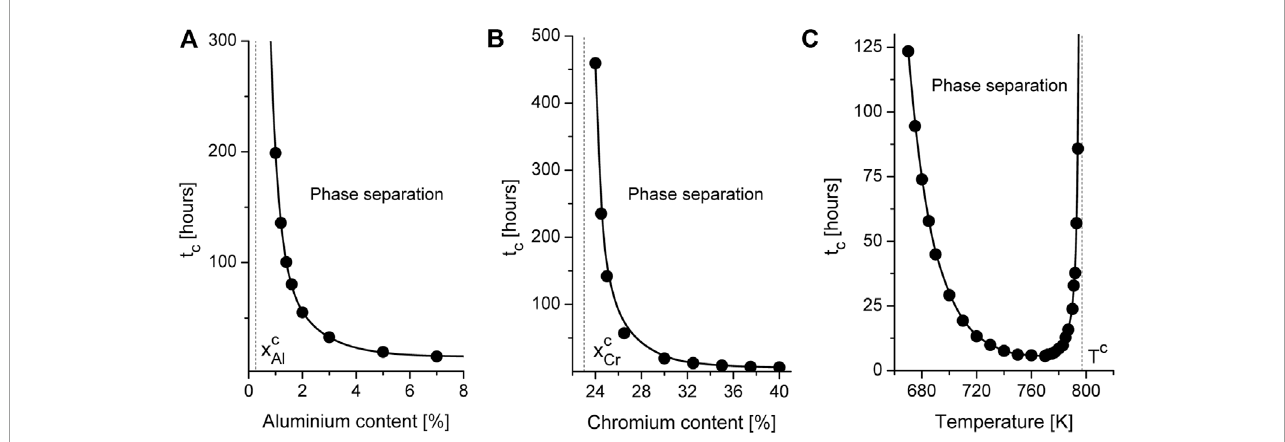
FIGURE 5 Dynamical diagram of phase decomposition at T = 710 K at fixed content of Cr ( x 0 diagram for Fe–30%Cr–5%Al.